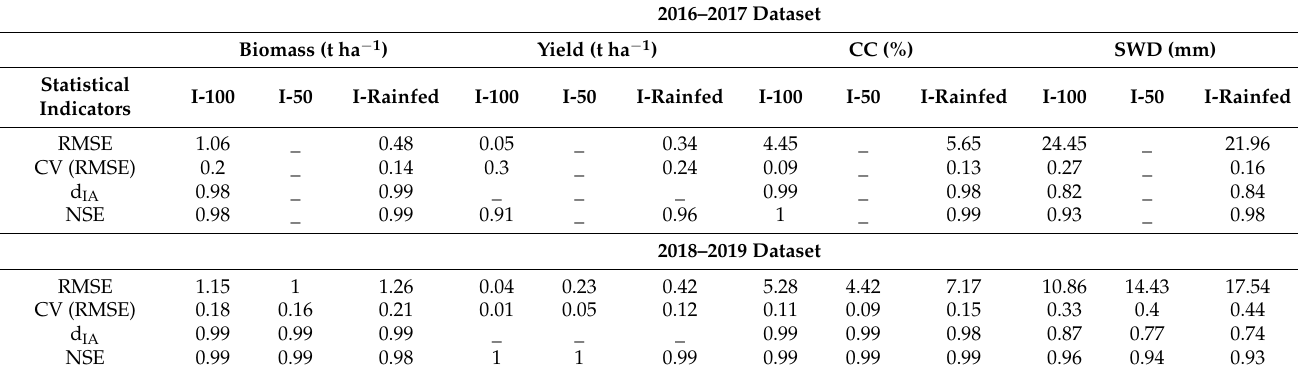
Table 8. Statistical indices derived for evaluating the performance of AquaCrop model in simulating biomass, yield, canopy cover, and soil water depletion for winter wheat (2016–2017 and 2018–2019 datasets) after S2-CC